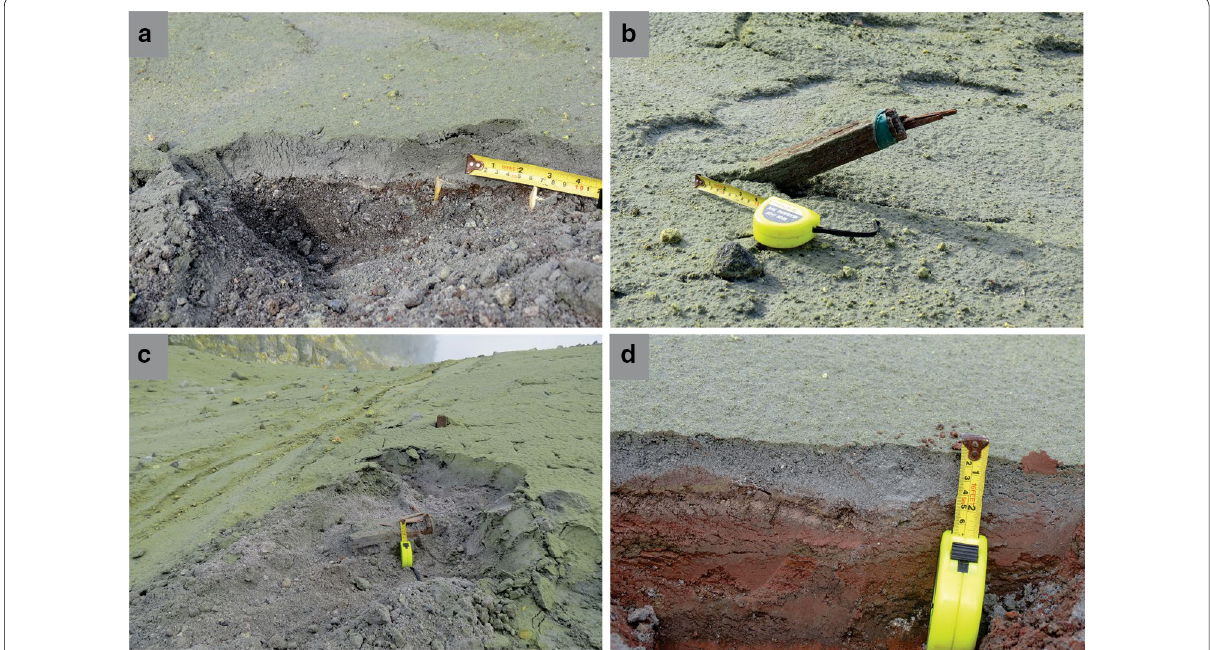
Fig. 7 Field images of the pyroclastic density current (PDC) and the impacts on pre-existing field markers. a Sheared yellow plastic pegs at the PDC base are clearly evident, as well as damaged wooden stakes ( b and c ) that are broken and now leaning or snapped away from the crater lake. d The deposit exhibits a weakly erosional basal contact and is fine-grained and poorly to very poorly sorted